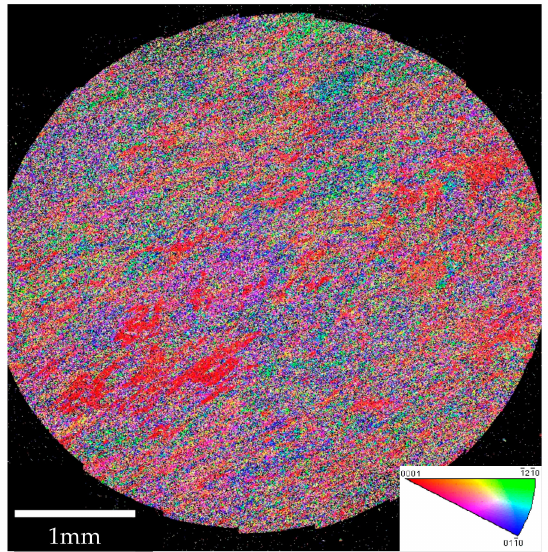
Figure 12. EBSD orientation map, obtained 5 mm below the fracture plane of a nominal Ti-407 specimen. The plane illustrated was parallel to the forging axis and perpendicular to the mechanical testing axis.